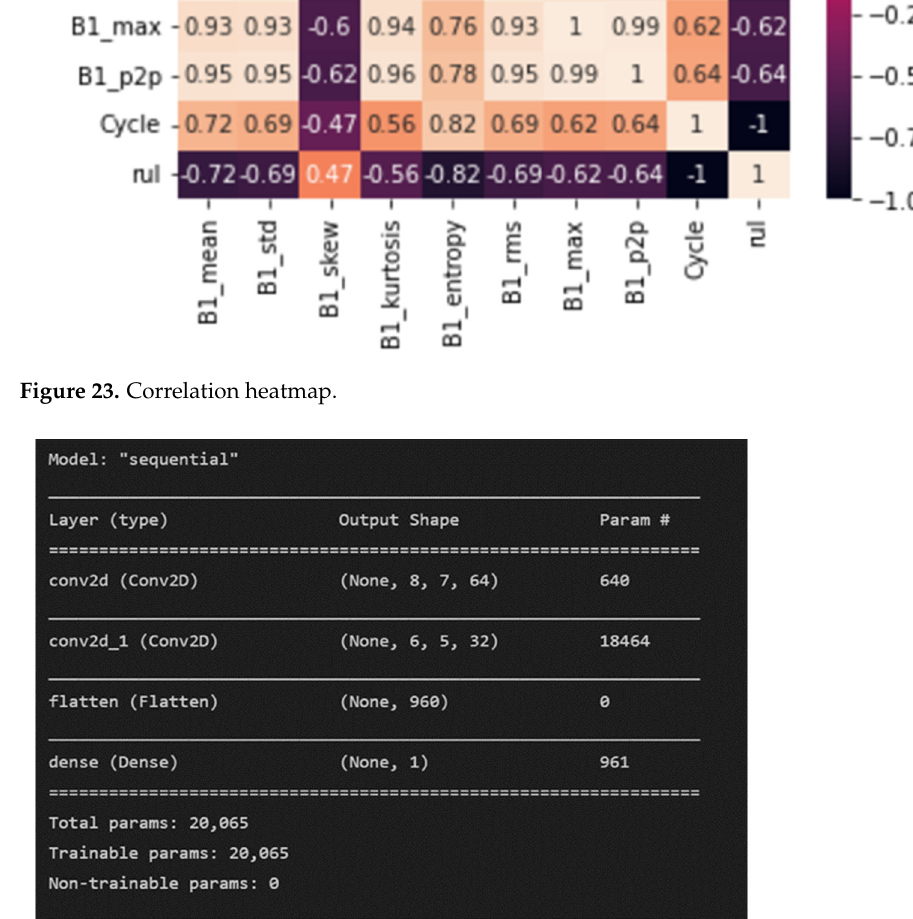
Table 5. RUL prediction CNN model accuracy metrics.